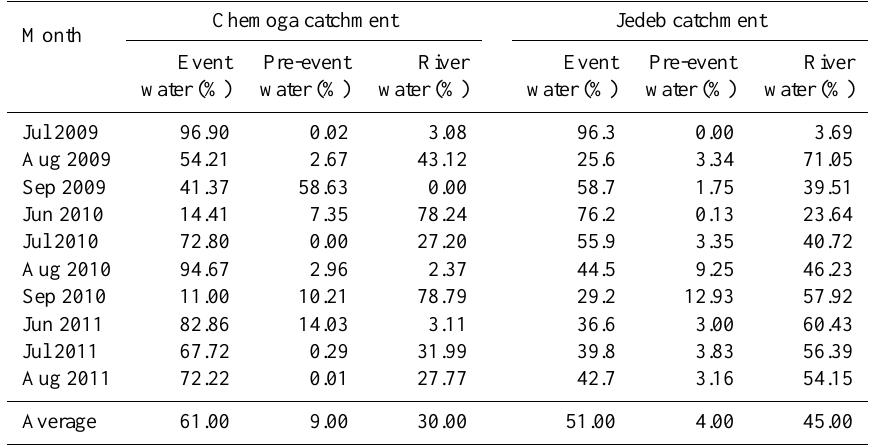
Table 5. Percentage of total uncertainty in event, pre-event and stream water concentrations during the wet season in the Chemoga and Jedeb catchments.